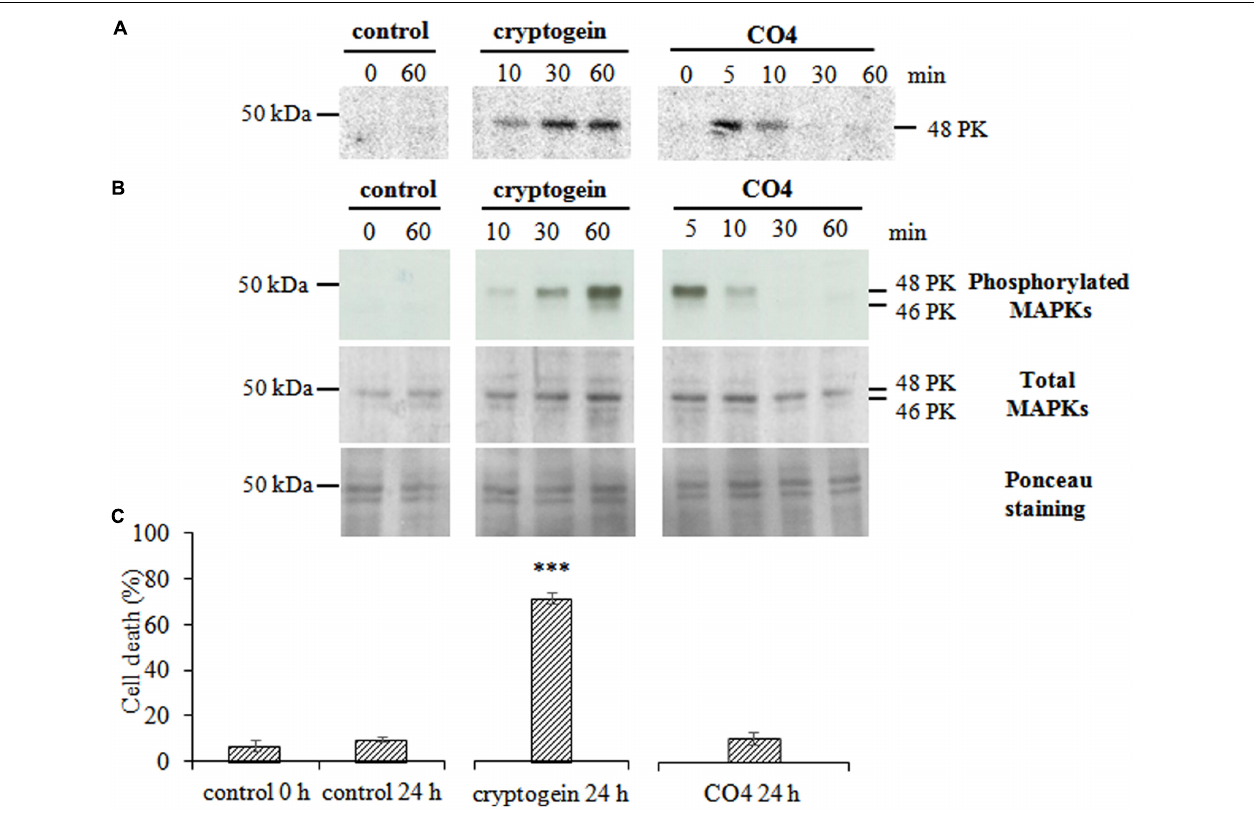
FIGURE 3 | CO4 induces a rapid and transient activation of MAPKs but does not induce cell death. Tobacco cells were left untreated (control) or treated with 50 nM cryptogein or 100 nM CO4, sampled at different time points, and then global protein extracts were prepared. (A) Protein kinase (PK) activity levels were analyzed by in-gel kinase assay using MBP as a substrate. The phosphorylation reaction was performed in the absence of Ca 2 + in the medium. Twenty µ g of total proteins were loaded per lane. The molecular mass (in kDa) is indicated on the left-hand side of the gels. The entire experiment was repeated independently three times. (B) Phosphorylated (active forms) and total MAPKs were immuno-detected using anti-human phospho-p44/42 and total MAPK antibodies, respectively. These data are representative of three independent experiments. (C) Cell death was measured by double staining using fluorescein diacetate and propidium iodide in tobacco cells treated or not with cryptogein or CO4 for 24 h. Data are the mean values ± SEs of three biological replicates. Statistical analysis was performed using Student’s T -test ( p ∗∗∗ < 0.001, n = 3).